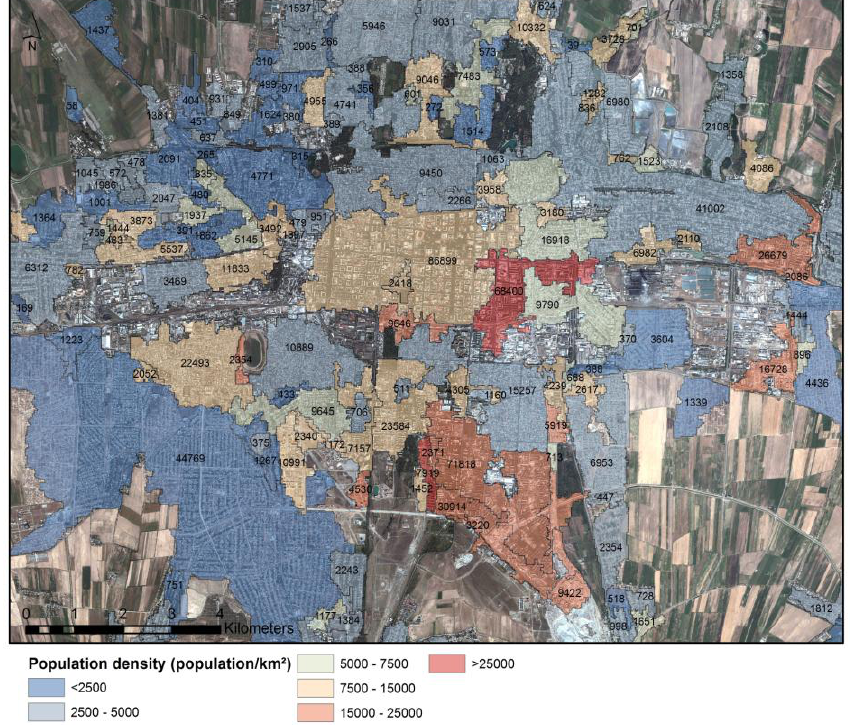
Figure 11. Population density per stratum in Bishkek. The numbers are the estimated population. Industrial areas are